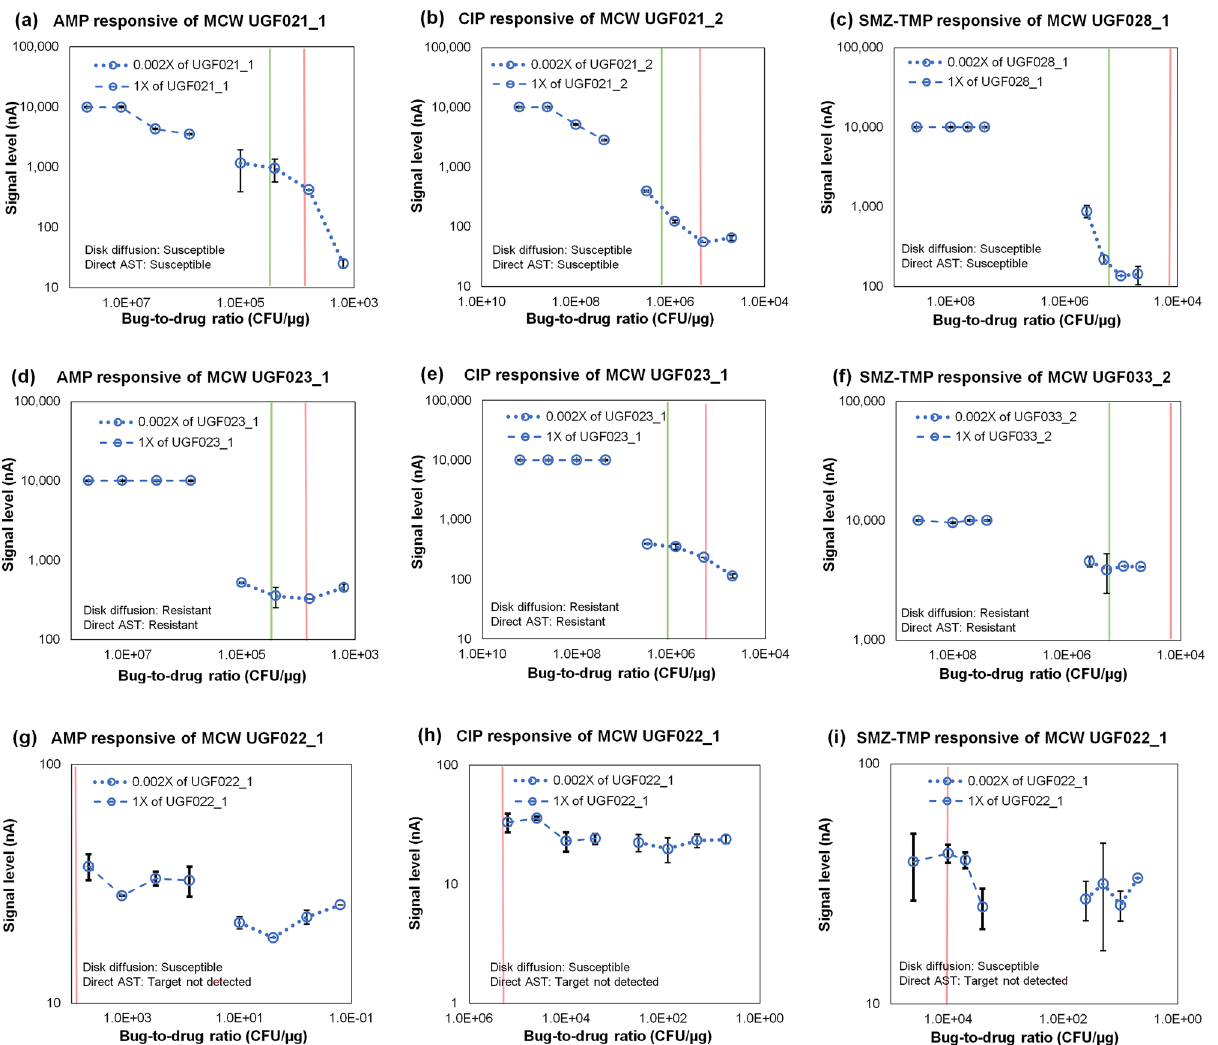
Figure 3. Representative results from MCW clinical feasibility study. ( a ) AMP susceptible, ( b ) CIP susceptible, ( c ) SMZ-TMP susceptible, ( d ) AMP resistant, ( e ) CIP resistant, ( f ) SMZ-TMP resistant, and Target not detected for UGF022_1 in ( g ) AMP, ( h ) CIP, and ( i ) SMZ-TMP AST. Each error bar represents 2 data